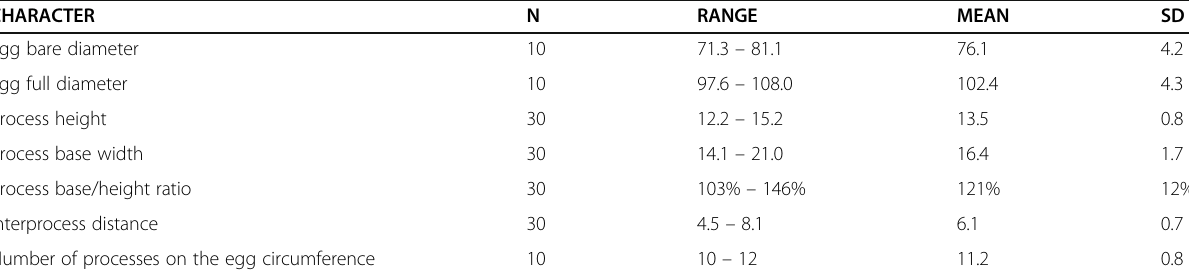
Table 7 Measurements [in μ m] of selected morphological structures of the eggs of Macrobiotus pallarii Maucci, 1954 from the topotypic population (IT.337) mounted in Hoyer ’ s medium (N – number of eggs/structures measured, RANGE refers to the smallest and the largest structures among all measured specimens; SD – standard deviation)